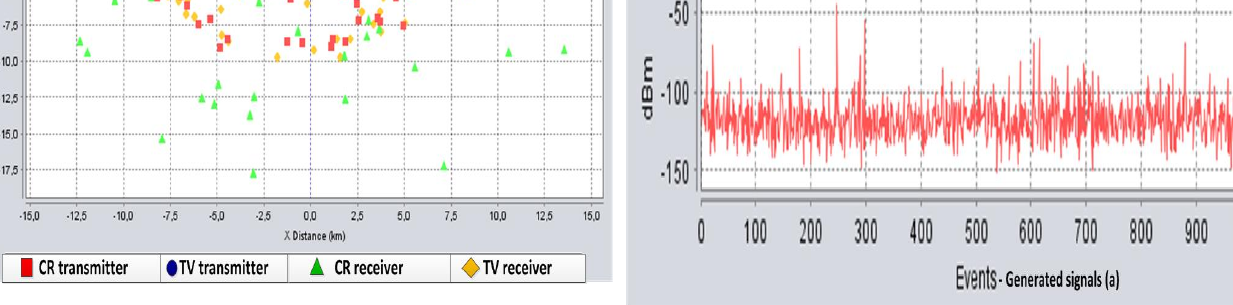
Figure 5. TV users and CR transmitter distribution scenario